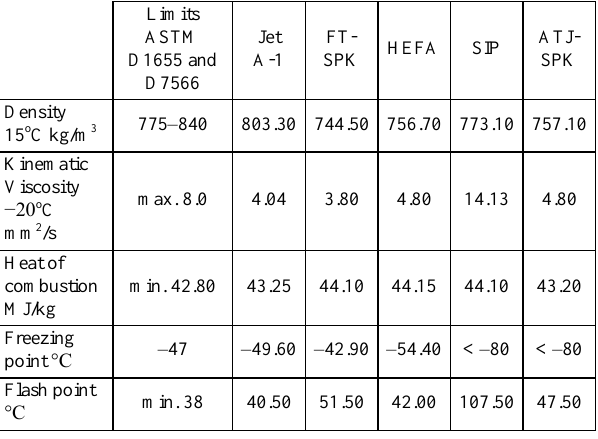
Table 2. Properties of selected fuels [32, 41, 43, 55, 60, 63,